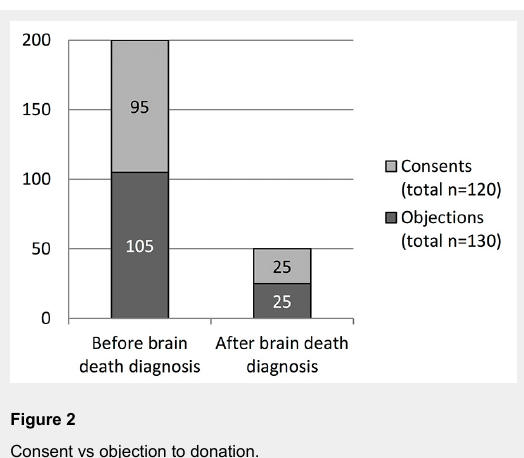
Consent vs objection to